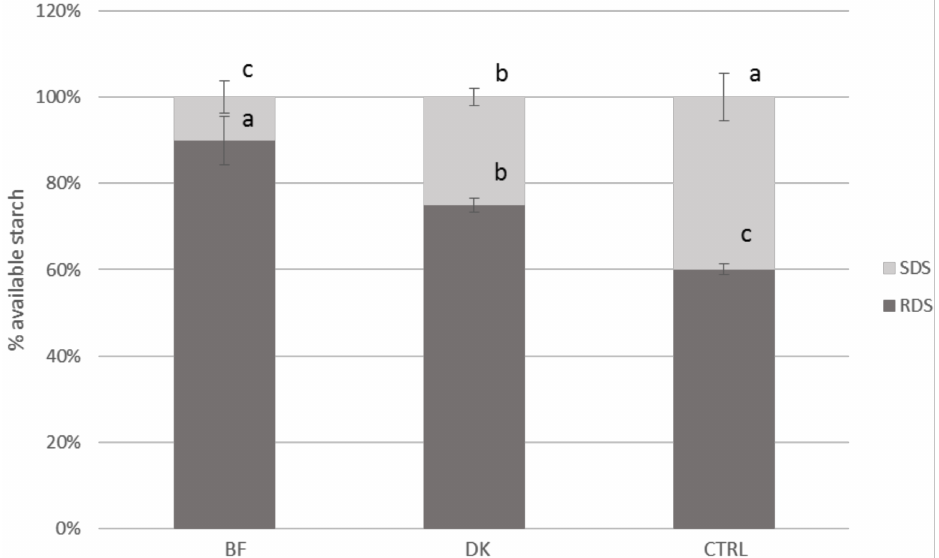
Figure 2. RDS and SDS expressed as percentages of the available starch (mean ± SD) ( n = 4) for the pasta samples. BF: pasta produced by enriching semolina with a durum wheat bran fraction; CTRL: control, pasta produced by traditional milling; DK: pasta produced by using micronized debranned kernels; RDS: rapidly digestible starch; SDS: slowly digestible starch. Statistical analysis was performed via one-way ANOVA and Bonferroni post hoc testing. Different letters indicate statistical significance ( p <